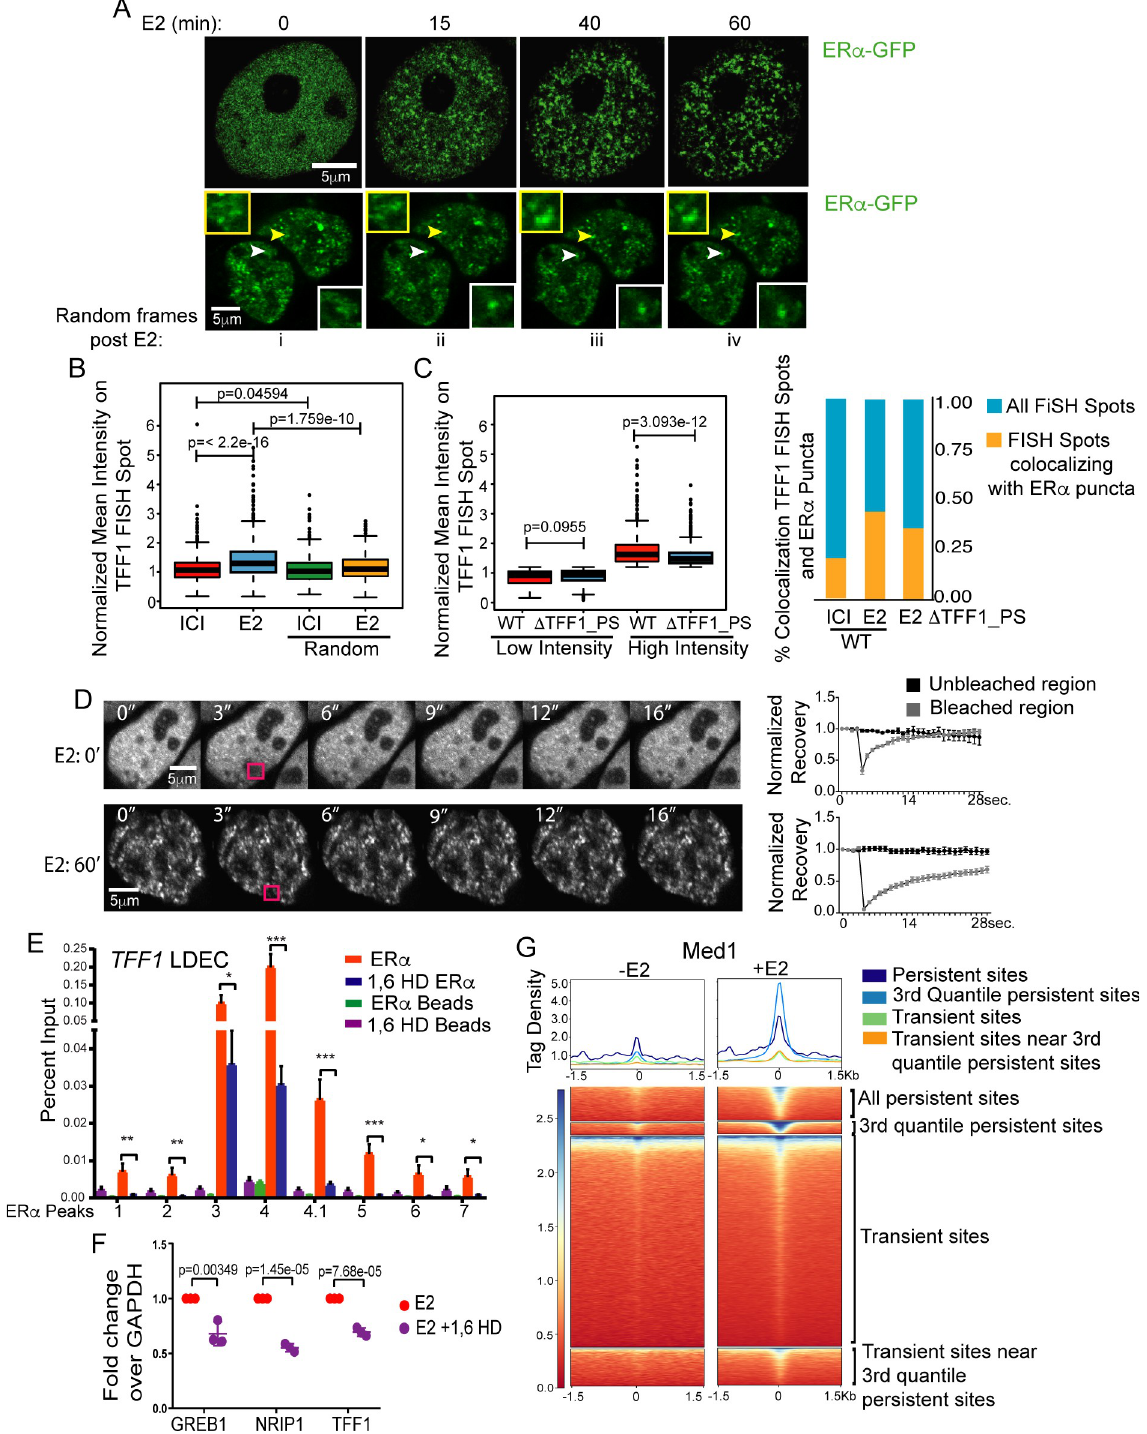
Fig 5. ER α puncta are formed on LDECs by coalescing. (A) GFP-ER α frames from movie showing ER α puncta appear upon E2 signaling during the mentioned time, post-E2 treatment (upper panel). ER α puncta appear upon E2 treatment and puncta of interest are marked by arrows (lower panel). Insets show the zoomed in images of marked puncta. (B) Plot showing the relative mean ER α intensity on TFF1 FISH spots and random regions upon ICI and E2 treatments. (C) Boxplot shows the mean intensities of low and high intensity ER α puncta on TFF1 FISH spots in WT and Δ TFF1_PS cells. p-values were calculated by Wilcoxon rank sum test. Right panel depicts the percent colocalization